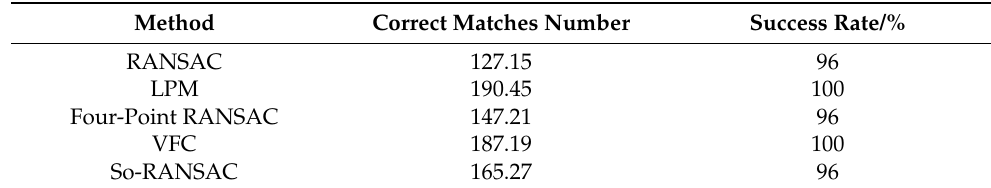
Table 3. The comparison of NCMs and SR on the pipeline data